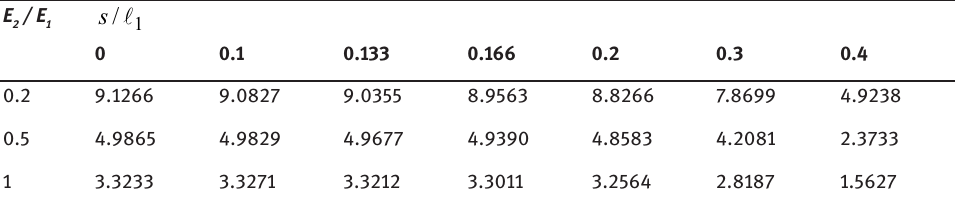
Table 2: The influence of the ratio 2 1 / E